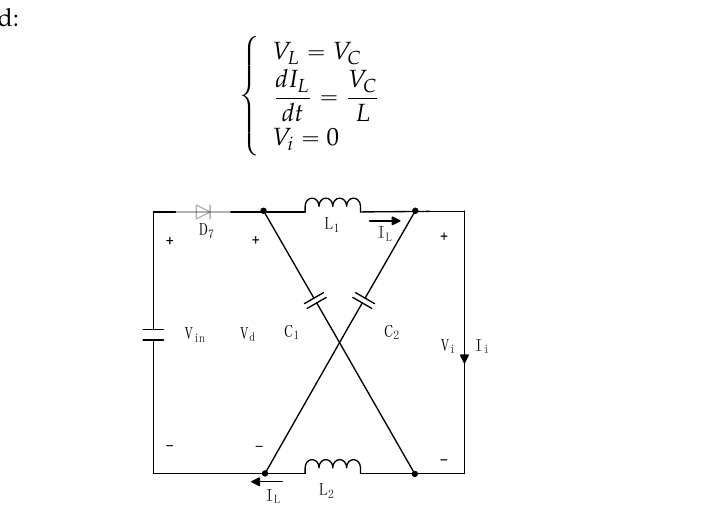
Figure 3. Equivalent circuit of the Z-source inverter in the shoot-through zero state.